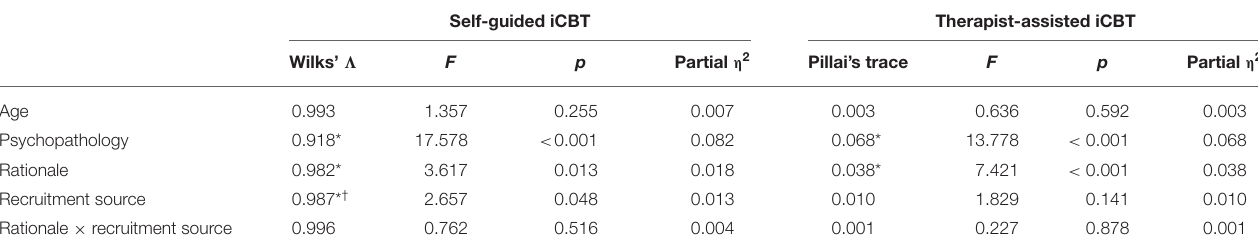
TABLE 3 | Multivariate effects for MANCOVA models examining the impact of a treatment rationale on attitudes toward iCBT.